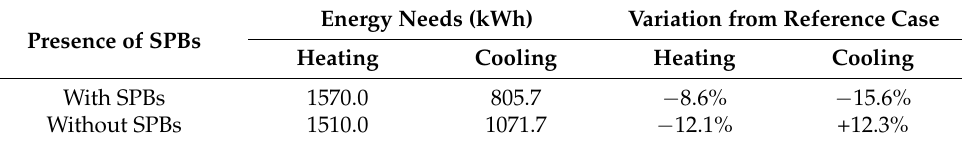
Table 8. Building’s annual energy needs and percentage change relative to the reference case with and without SPBs.